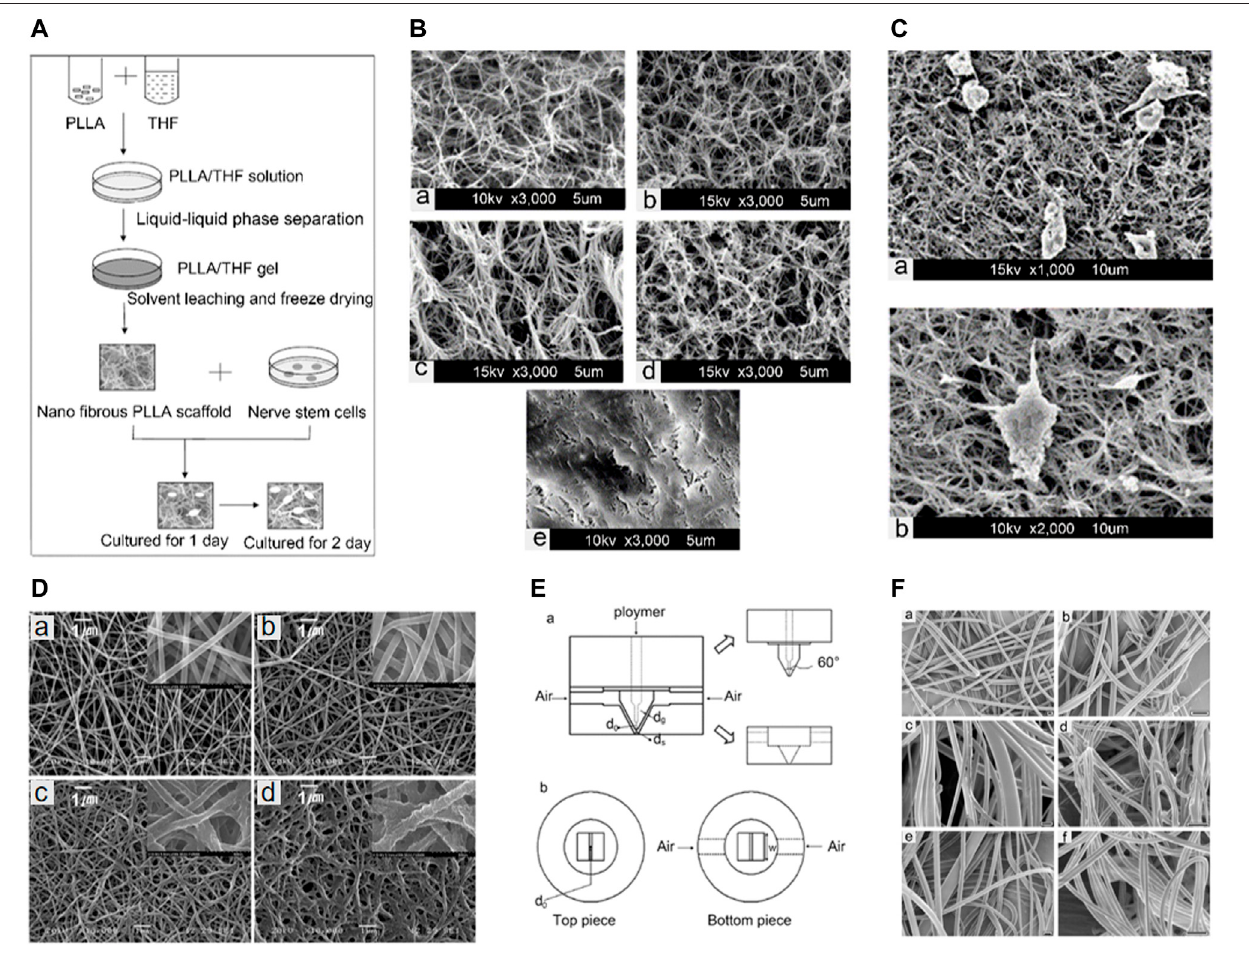
FIGURE 2 | (A) Schematic illustration of the fabrication of polymeric fi ber scaffolds by phase separation and in vitro cell culture. (B) SEM micrographs of scaffolds prepared with PLLA/THF concentrations of (a) 2% w/v; (b) 3% w/v; (c) 5% w/v; (d) 7% w/v; and (e) 9% w/v. (C) SEM images of PLLA nano- fi brous scaffolds (5% w/v) loaded with C17-2 cells after culture for 1 day: (a) magni fi cation of × 1000; (b) magni fi ed view of a differentiated cell with a short neurite ( × 2000). Reproduced with permission(Yangetal.,2004).2003,Elsevier. (D) SEMmicrographsofpolyelectrolytemultilayer-coatednylon6 fi berswith(a)nylon6 fi bersalone(withoutcoating); (b) one bilayer; (c) fi ve bilayers; and (d) 10 bilayers of PSS and PAH. Reproduced with permission (Park et al., 2008). 2007, Wiley. (E) Schematic diagram of the melt- blowingdie:(a)sectionaland(b)end-on viewsofthetwopieces. (F) RepresentativeSEMmicrographsofthetypical fi bermatsfrom(a)PS-1,(b)PS-3,(c)PP-1,(d)PP-3, (e) PBT-1, and (f) PBT-2 melt-blowing runs. Reproduced with permission (Ellison et al., 2007). 2007,